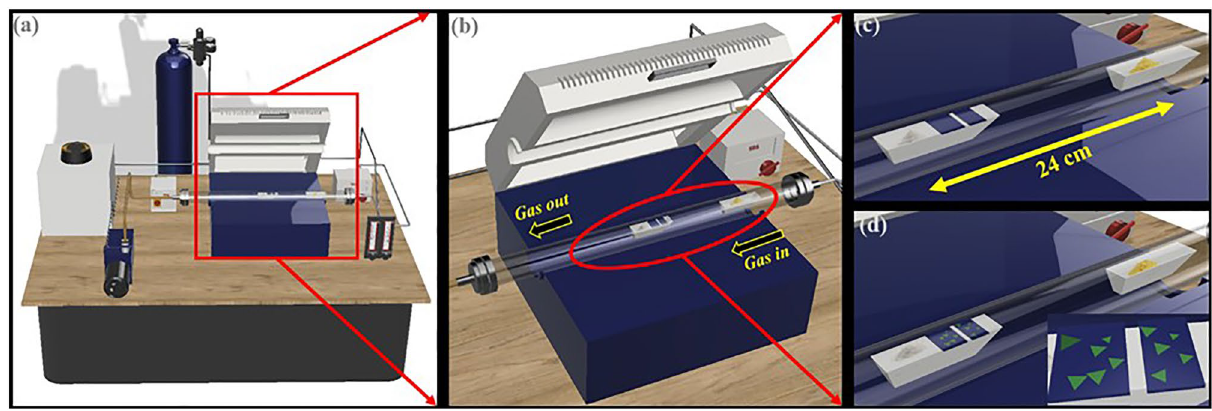
Figure 1. Pictorial representations of ( a ) Indigenously laboratory developed APCVD setup for synthesis of monolayer MoS 2 . ( b ) Horizontal split furnace and quartz tube. ( c ) Arrangement of precursors and substrate inside the furnace at constant heating zone before growth and ( d ) after